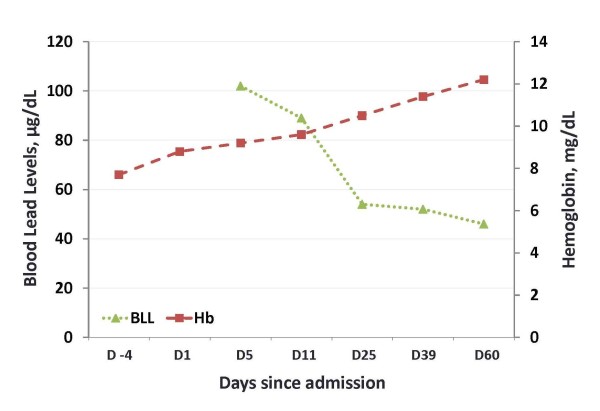
Trends of hemoglobin and BLLs of the patient at diagnosis and during chelation therapy. First emergency room visit corresponds to day -4; the day of admission during the second emergency room visit is designated as day 1.